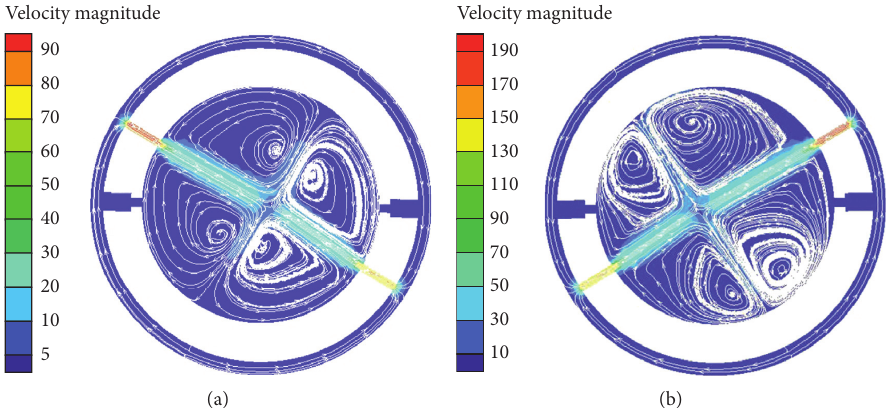
Figure 10: Velocity distribution contours at a cross-section of the damping valve in extension stroke at (a) t � 0.05s and (b) t � 0.1s. Pressure